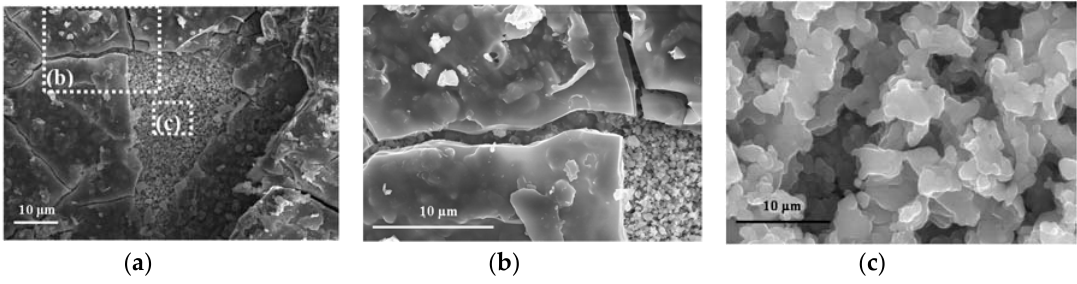
Figure 10. ( a ) Flaking of the basic copper chloride layers formed on copper exposed to a marine atmosphere with high chloride deposition rates; ( b ) SEM micrograph of the cracked surface of basic copper chlorides; ( c ) SEM micrograph of the cuprite surface.